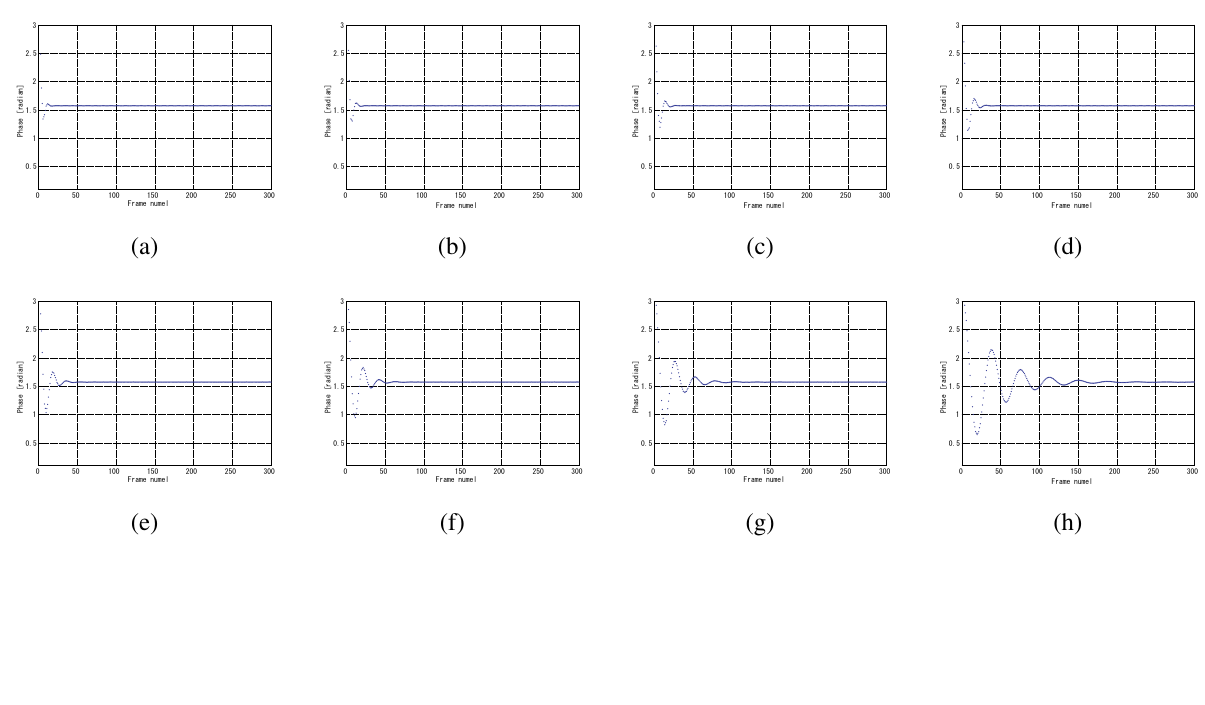
Figure 14. Overshoot phenomena of different coefficient k of LPF when G = 4 . 0 × 10 − 9 , (a) k = 0.0156, (b) k = 0.0125, (c) k = 0.2500, (d) k = 0.3750, (e) k = 0.5000, (f) k = 0.6250, (g) k = 0.7500, (h) k = 0.8750.